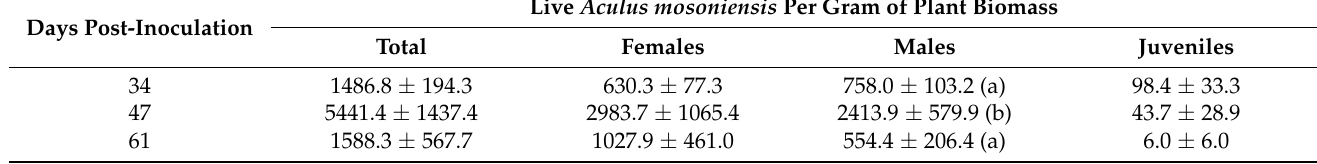
Table 2. Number of live Aculus mosoniensis (total, i.e., adults and juveniles), and live adult females, and males, and juveniles per gram of plant biomass collected from Ailanthus altissima (mean ± SE) at 34, 47, and 61 days post-inoculation, respectively, in the field experiment performed in 2019. Values followed by letters in brackets differ significantly at p = 0.05.